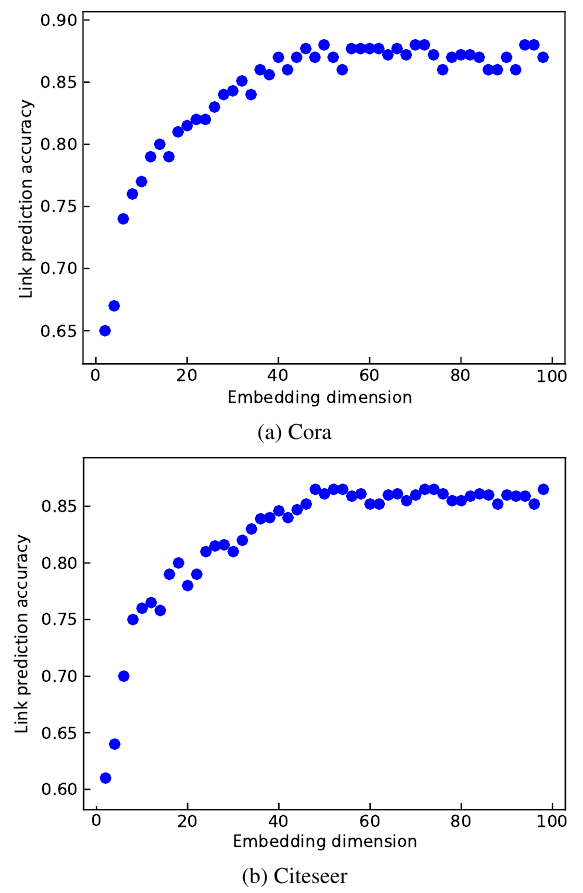
Fig. 3 Link prediction accuracy of the test set over different embedding dimensions of Cora and Citeseer.